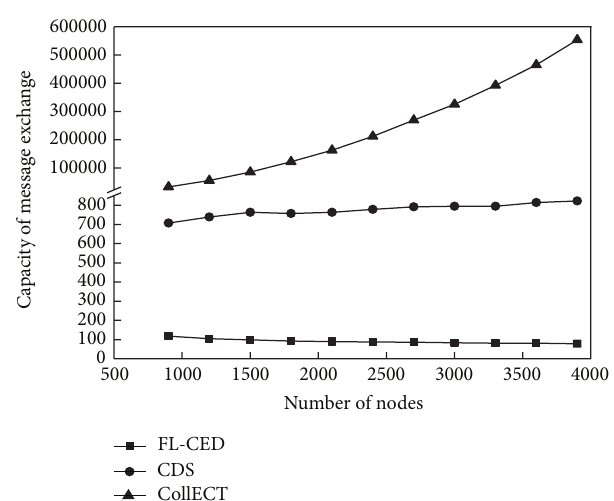
Figure 10 reflects accuracy of three algorithms;